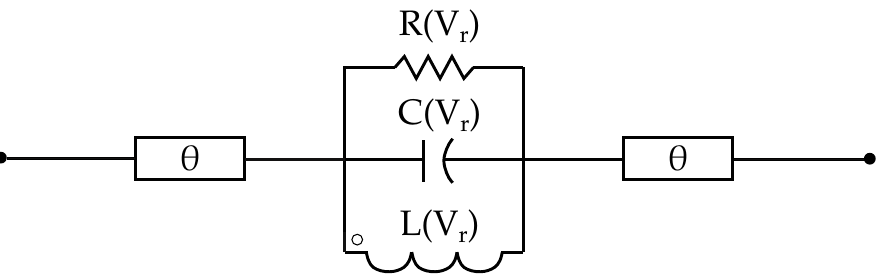
Figure 8. Equivalent circuit model of the coupling between dielectric and ring resonators: reduced model.